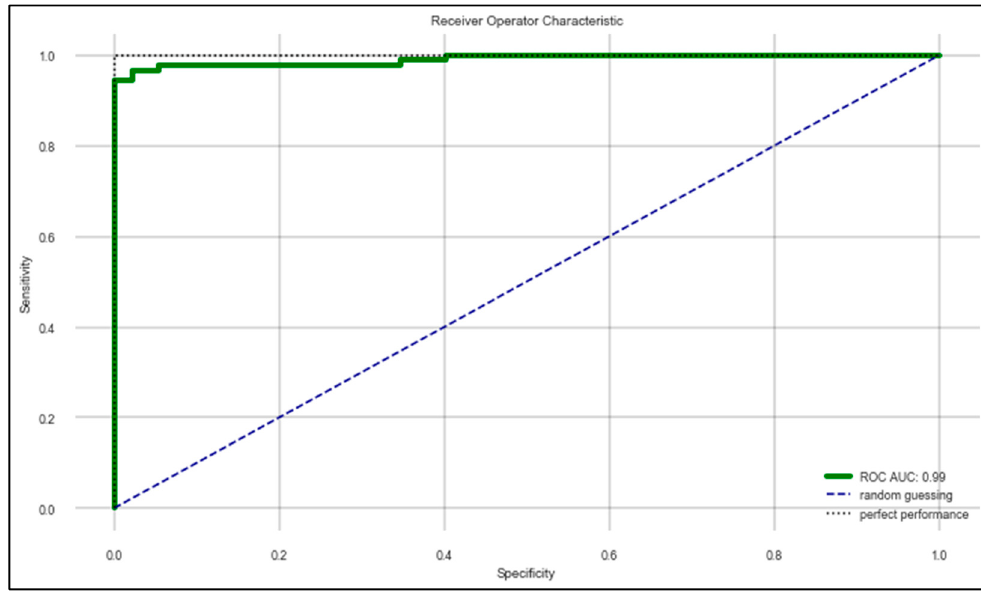
Figure 5. ROC–AUC of random forest classifier mentioned in Table 7. Table 8. Confusion catrix values for each subject as tests of best performing classifier